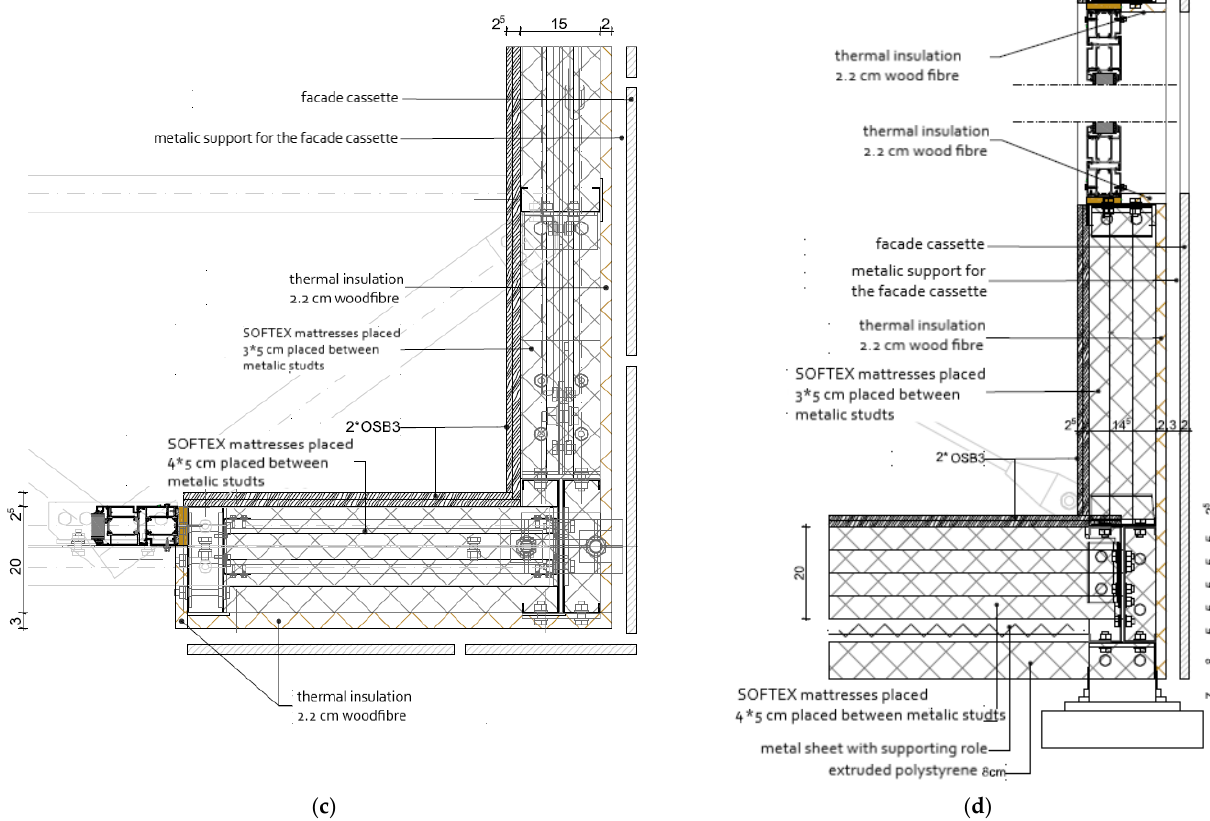
Figure 9. Constructive details at junctions: ( a ) Roof—exterior wall-intermediate floor; ( b ) Ridge zone; ( c ) Exterior corner—window connection, ( d ) Exterior wall—floor in contact with the exterior.